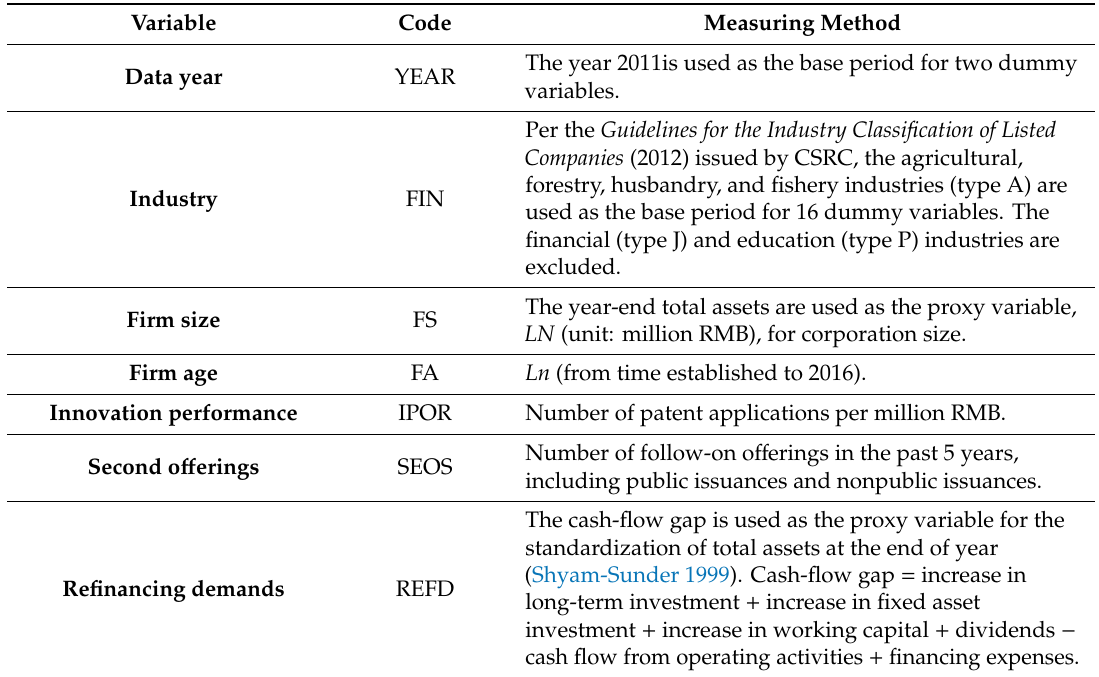
Table 1. Measurement of control